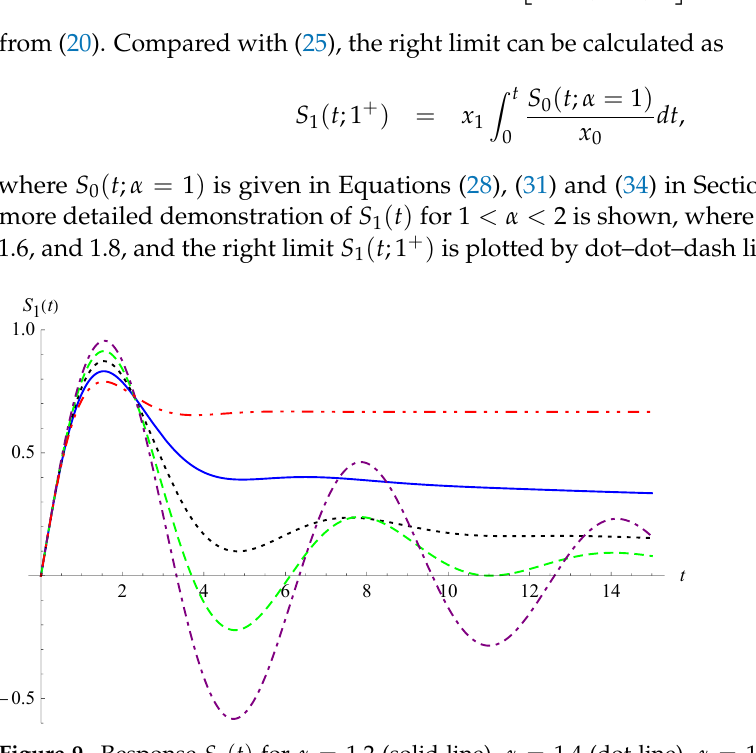
Figure 9. Response S 1 ( t ) for α = 1.2 (solid line), α = 1.4 (dot line), α = 1.6 (dash line), α = 1.8 (dot–dash line); the dot–dot–dash line is for the limit S 1 ( t ;1 + )